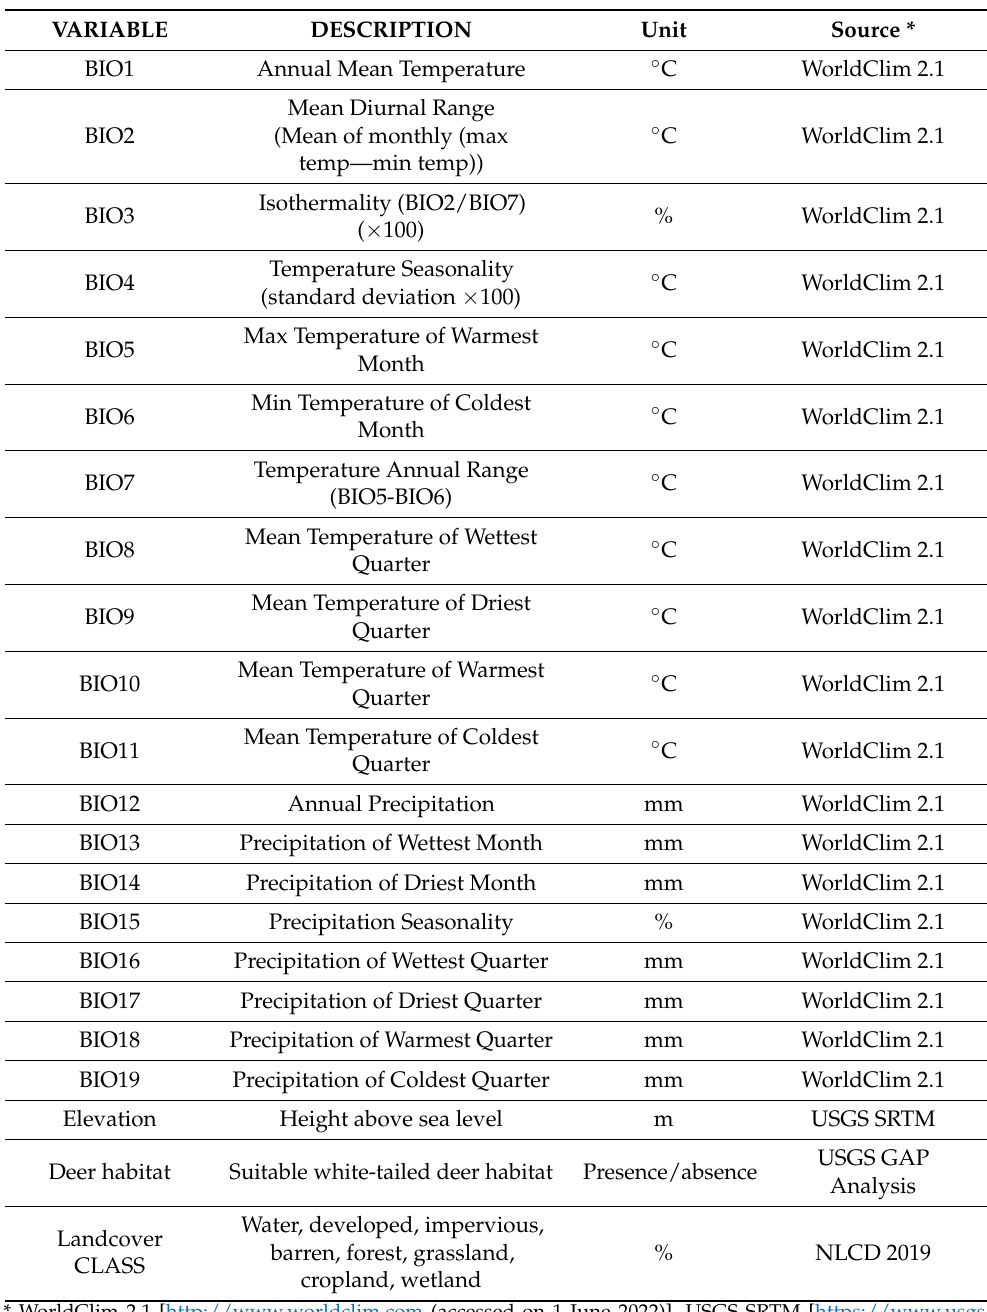
Table 1. Descriptions and sources of each of the 19 bioclimatic variables (WorldClim 2.1) and other environmental predictor variables ( n = 29) used in model